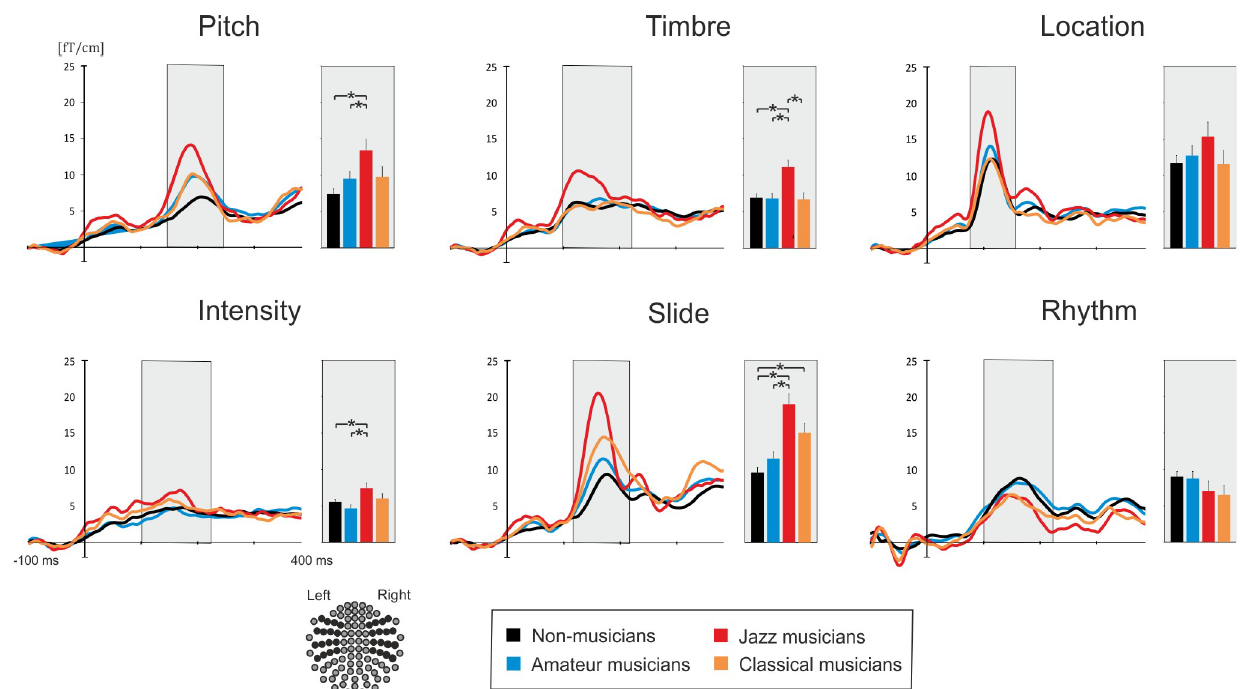
Fig 3. Average areal mean curves and MMNm amplitudes obtained for each musical group and six types of deviants. Histograms represent mean values of MMNm responses. Asterisks mark significant results of Bonferroni-corrected planned comparisons ( p < 0.05). A schematic picture of the gradiometers selected for calculating areal mean curves (dark circles) is at the bottom left.